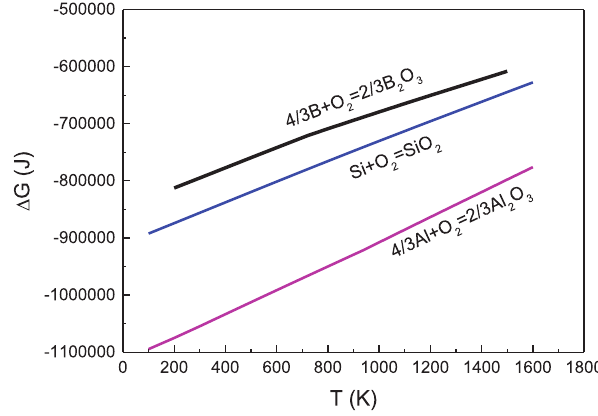
Figure 2: The oxygen potential figure of B 2 O 3 , SiO 2 and Al 2 O 3 cal- culated by Factsage 6.4.